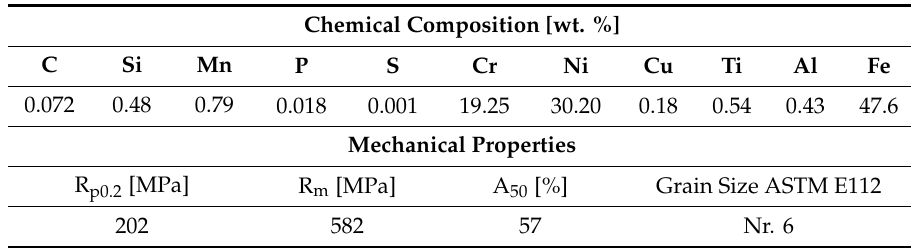
Table 2. Chemical composition and mechanical properties of Incoloy 800HT nickel alloy according to the inspection